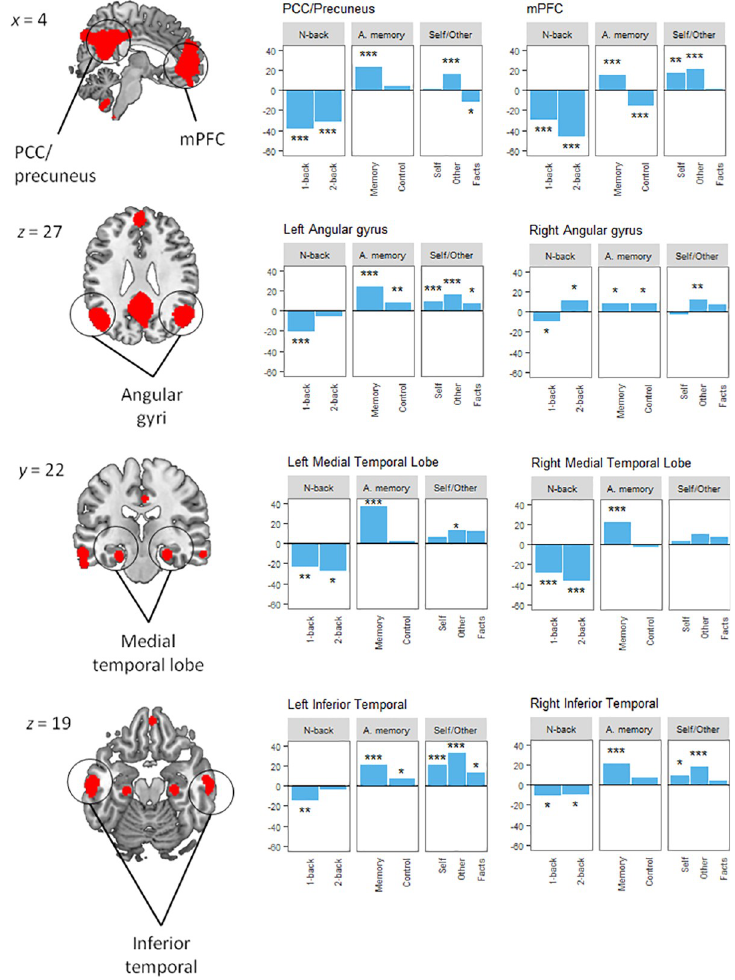
Fig 4. Activation in DMN regions in ROI analysis. Vertical axis shows parameter estimates. � p < 0.05, �� p < 0.01, ��� p < 0.001(the last being equivalent to a Bonferroni corrected p < 0.05).